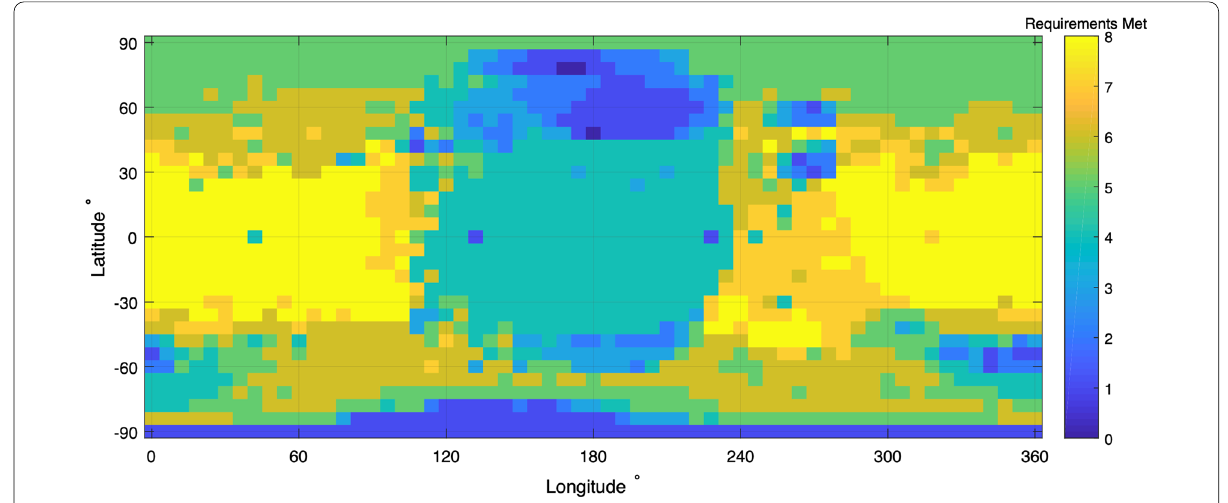
Fig. 12 Map of Phobos. Number of requirements met as a function of location